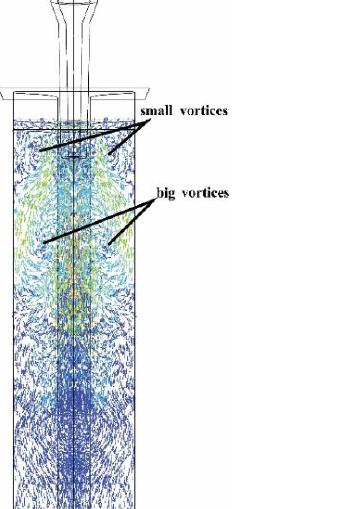
Figure 6. Flow pattern obtained from outside of mold by mathematical modeling: ( a ) narrow face view, ( b ) wide face view.